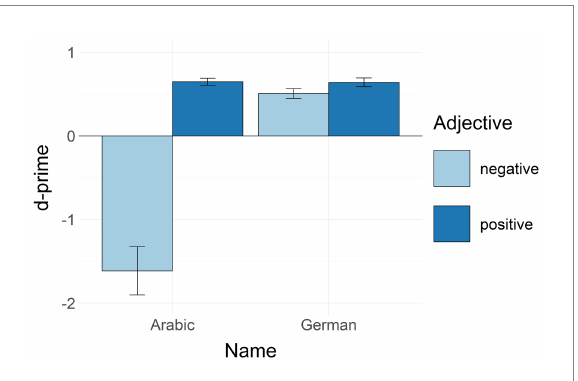
FIGURE 2 D-primes in the GNAT aggregated by name and adjective. Bars represent mean values. Whiskers represent standard errors. D-prime values of 0 or below indicate that participants were unable to discriminate signal from noise or did not perform the task as instructed.